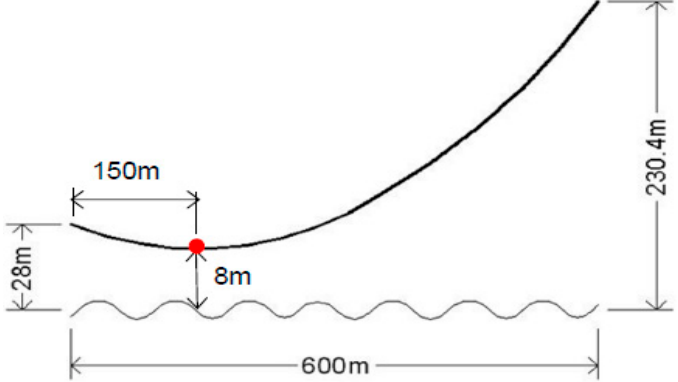
Figure 6. Three-phase non-uniform transmission line used in the example in Section 3.1. A second-degree polynomial equation was utilized to approximate the conductors’ height, as presented in [23]. There was a 10 m separation between the conductors.